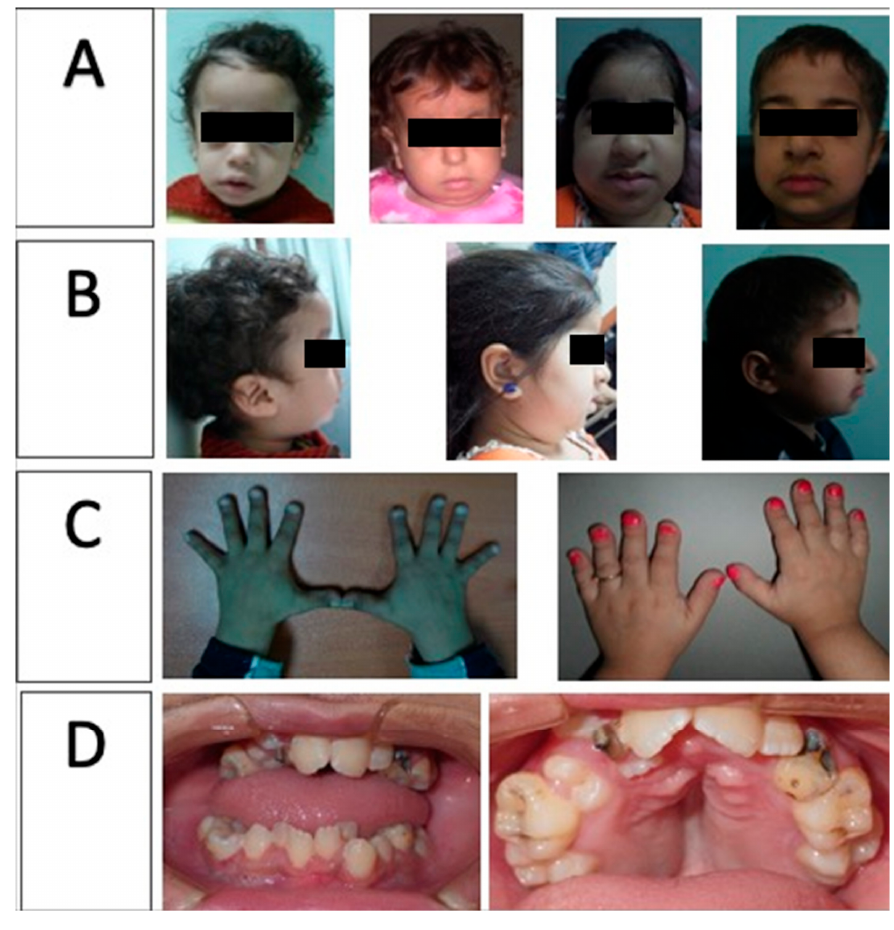
Figure 1. ( A ) Frontal view: characteristic facies; ( B ) profile view: beaked nose and hanging columellas; ( C ) stubby hands with bulbous and dystrophic nails; ( D ) crowding of teeth, malposition, and collapsed palatal shelves with midline groov- ing.